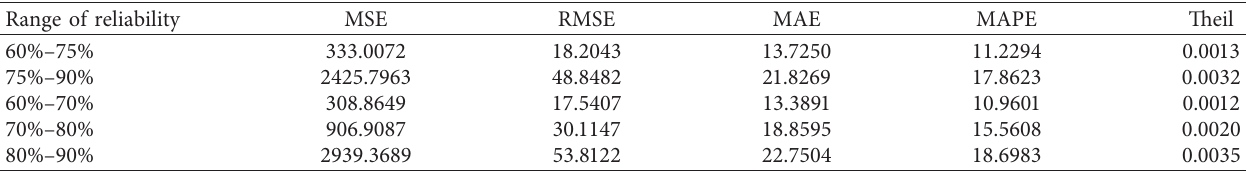
Figure 8: Convergence curves for different target block time reliability. Table 3: Evaluation metrics of